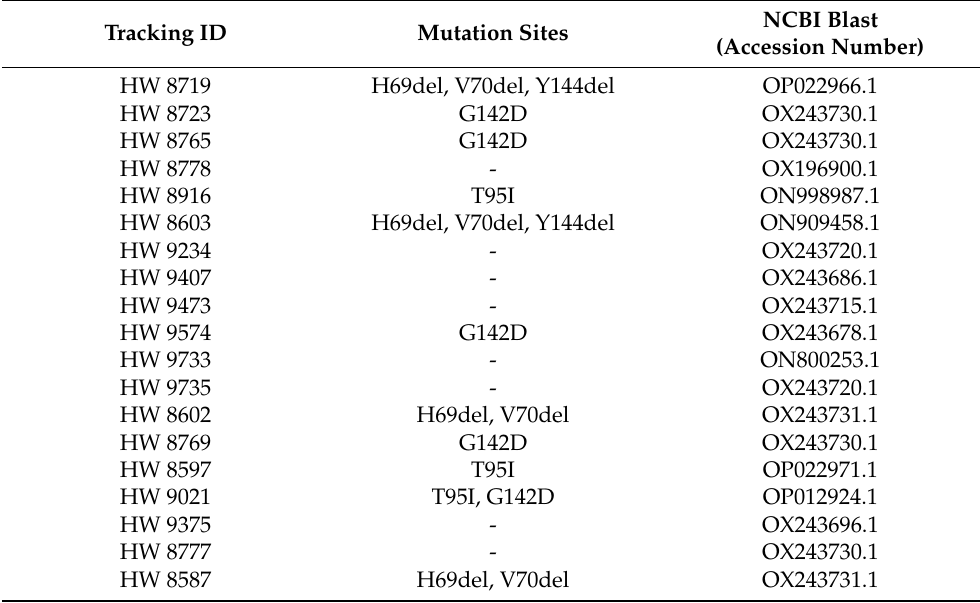
Table 4. Mutation analysis of SARS-CoV-2 S partial gene by using CoVsurver and the identification of SARS-CoV-2 by comparing with reference sequence on the NCBI